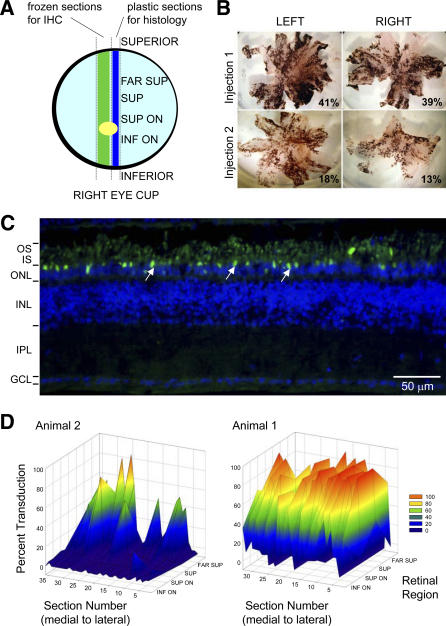
Immunohistochemical Analyses of GFP Expression in Treated Retinas(A) Schematic of the right eye cup that shows how the retina was apportioned for analyses. The right eye of each animal was bisected along the vertical meridian. One half was processed for immunohistochemical (IHC) analyses and the other for detailed histological analyses. The retinal sections were divided into four regions (FAR SUP, SUP, SUP ON, and INF ON) to simplify analyses.(B) Flat-mount retinas stained to reveal pattern of transduction obtained following neural tube delivery of 0.5 μl of EF1α-PLAP virus (109 TUs/ml). The percent transduction for the left (left panel) and right (right panel) eyes of two of the three animals analyzed is shown.(C) FAR SUP region of a treated retina immunostained for GFP. Arrows indicate staining in photoreceptor cell bodies. GFP staining is also visible in the inner segments and outer segments of these cells. GCL, ganglion cell layer; INL, inner nuclear layer; IPL, inner plexiform layer; IS, inner segments; ONL, outer nuclear layer; OS, outer segments.(D) Topographical distribution of GFP-expressing cells in treated right eyes from treated animals 2 (left) and 1 (right). The percent transduction of each of the four retinal regions was plotted on the z-axis as a function of location along the superior–inferior axis of the eye (x-axis) and distance from the midline (y-axis). These analyses represent the results obtained from serial sections over 500 μm beginning at the midline axis and moving laterally.